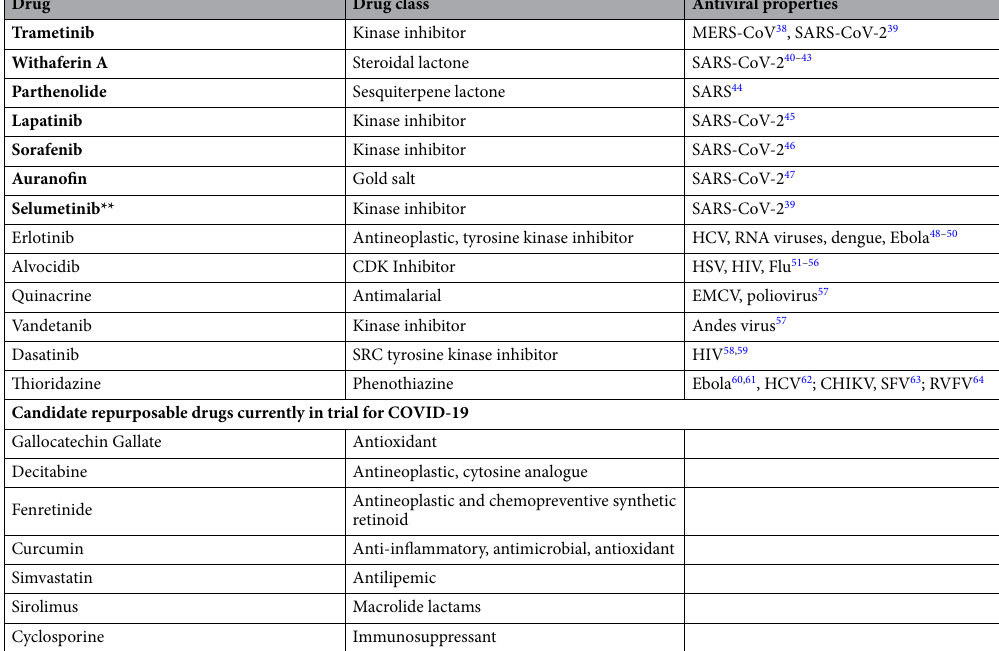
Table 2. Top candidate drug findings for repurposing. Top candidate drug findings for repurposing. Candidate drugs are FDA-approved or currently undergoing trial; have reported antiviral properties and/ or anticoronavirus properties (bold). Several of the candidate drugs identified for repurposing are already undergoing clinical trial for COVID-19. HCV hepatitis C virus; CHIKV Chikungunya virus; SFV Semliki Forest virus; RVFV Rift Valley fever virus. ** Also identified in 2 different COVID-19 patient datasets.